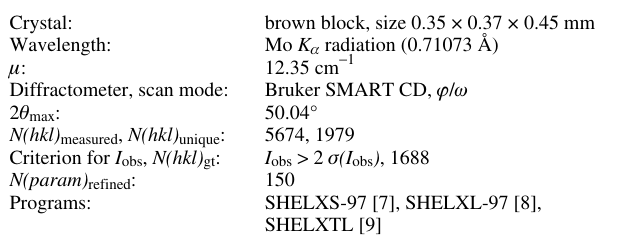
Table 1. Data collection and handling.